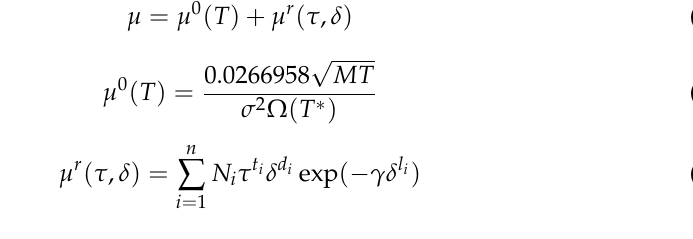
Table 2. Nitrogen coefficients for the collision integral equation [57].